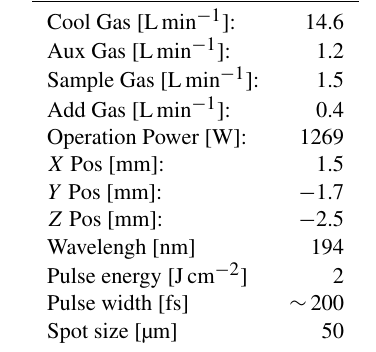
Table 2. Instrumental operating conditions for the MC-ICP-MS and